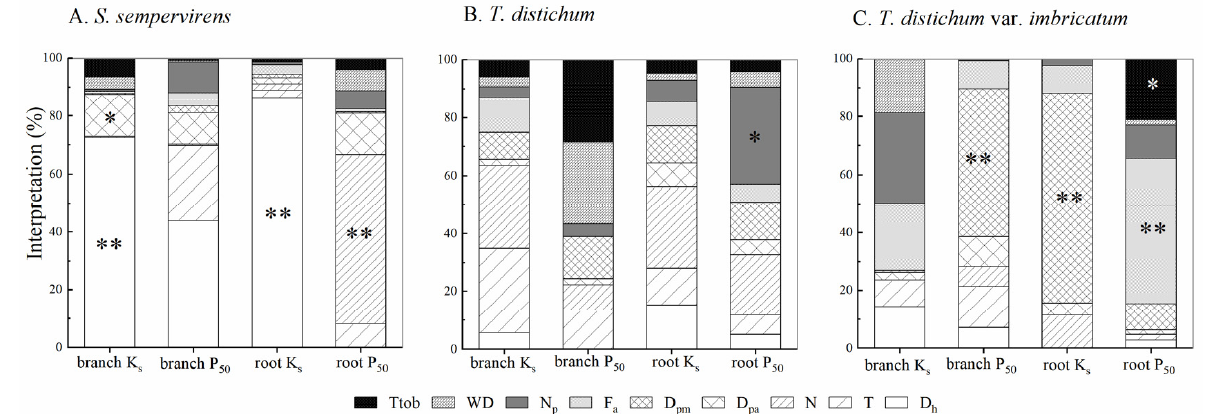
Figure 7. Interpretation of the relationships between structural traits and functional traits ( K s on P 50 ) in the xylem of the branches and roots within taxa after the redundancy analysis. ( A ): S. sempervirens ; ( B ): T. distichum ; ( C ): T. distichum var. imbricatum . *, 0.01 < p < 0.05; **, p < 0.01.